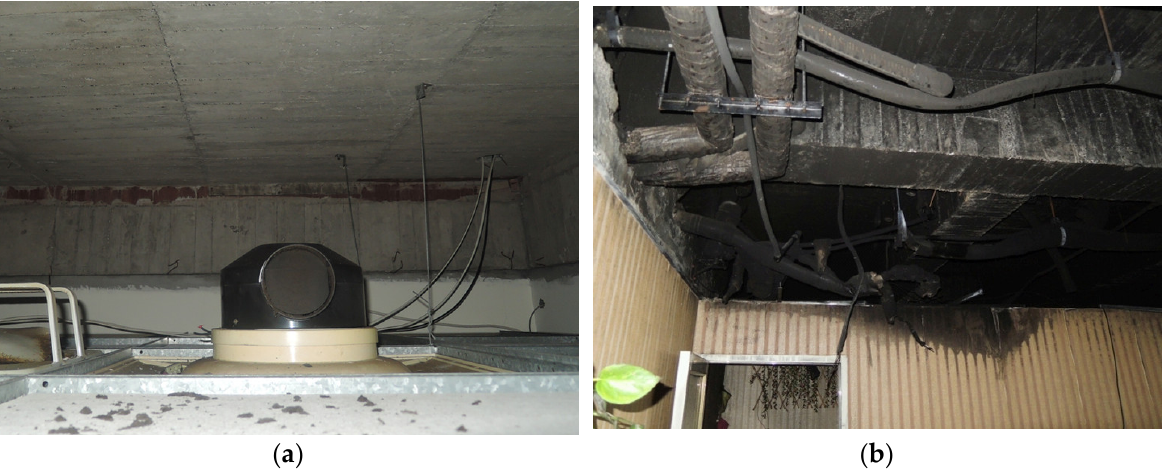
Figure 4. ( a ) The wall is connected to the floor structure above (a real photo of the scene, but not an institution mentioned in this paper). ( b ) The wall is not connected to the floor structure above (a real photo of the scene, but not an institution mentioned in this paper).